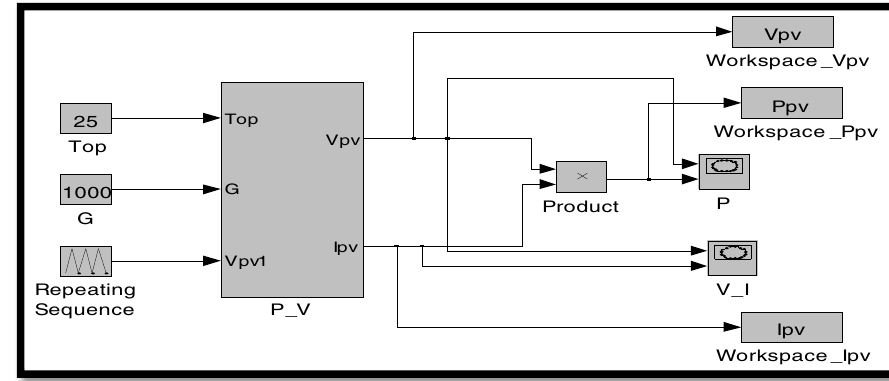
Fig. 4. Simulink of solar PV model.